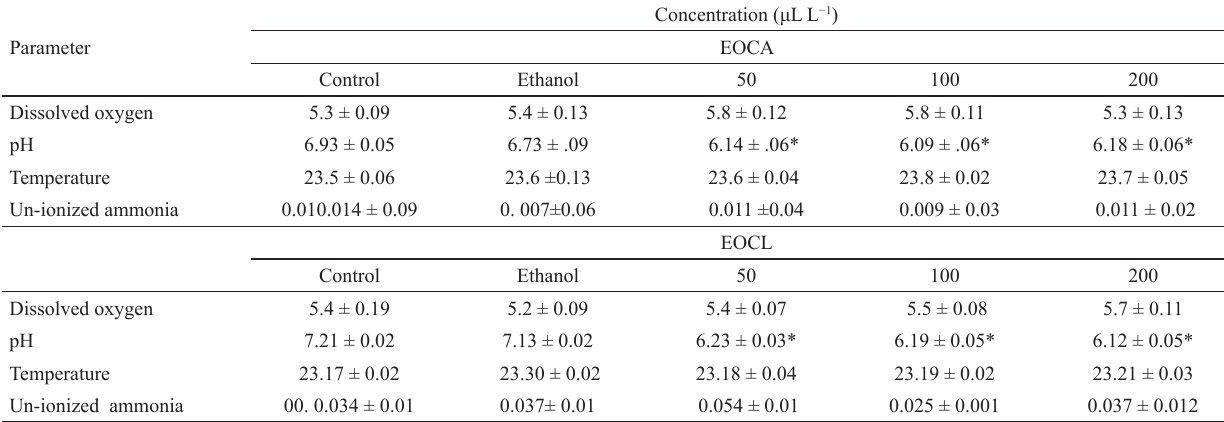
Tab. 2. Water parameters after 8 h exposure of Rhamdia quelen to the essential oils of Citrus x aurantium (EOCA) and Citrus x latifolia (EOCL) added to the water. *significantly different from control (P < 0.05). Values are means ± SEM. Dissolved oxygen and un-ionized ammonia were expressed as mg/L -1 and temperature as